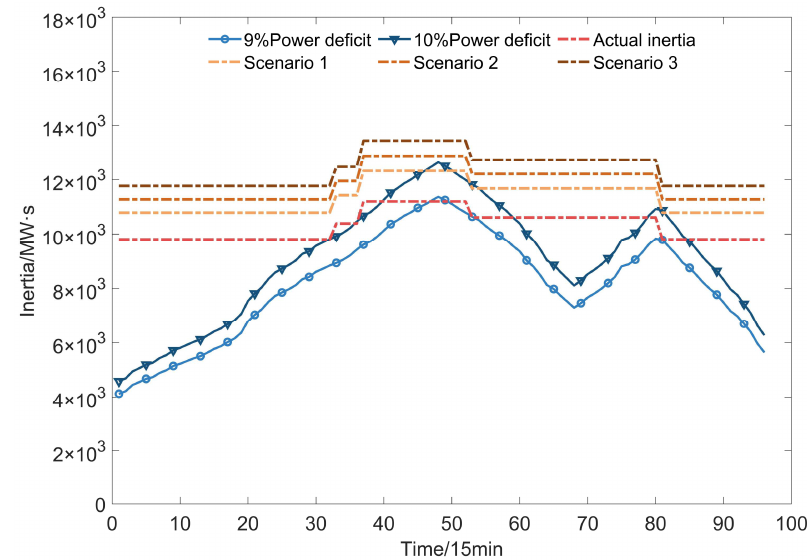
Figure 7. Results with different inertia margin coefficients for intraday scheduling.